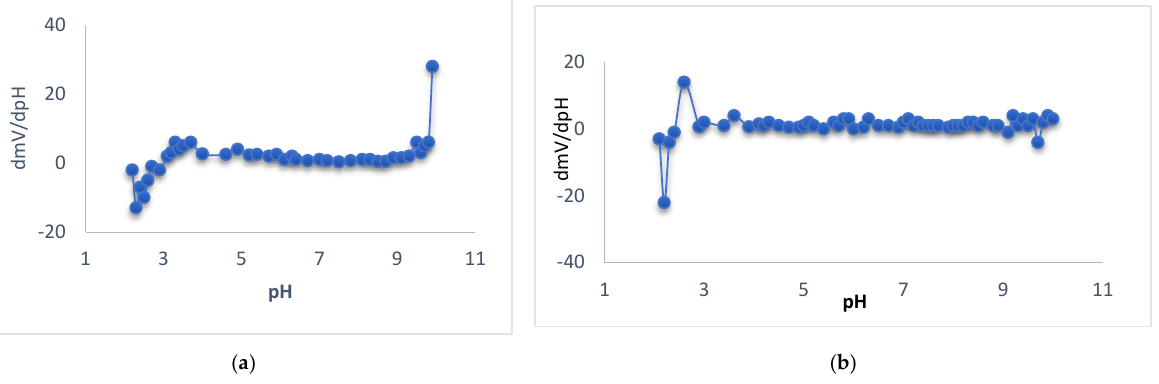
Figure 5. Representation of ∂ mV/ ∂ pH against pH value of Ca sensor for 10 − 2 M Ca 2+ solutions for the sensors type I ( a ) and type III ( b ).